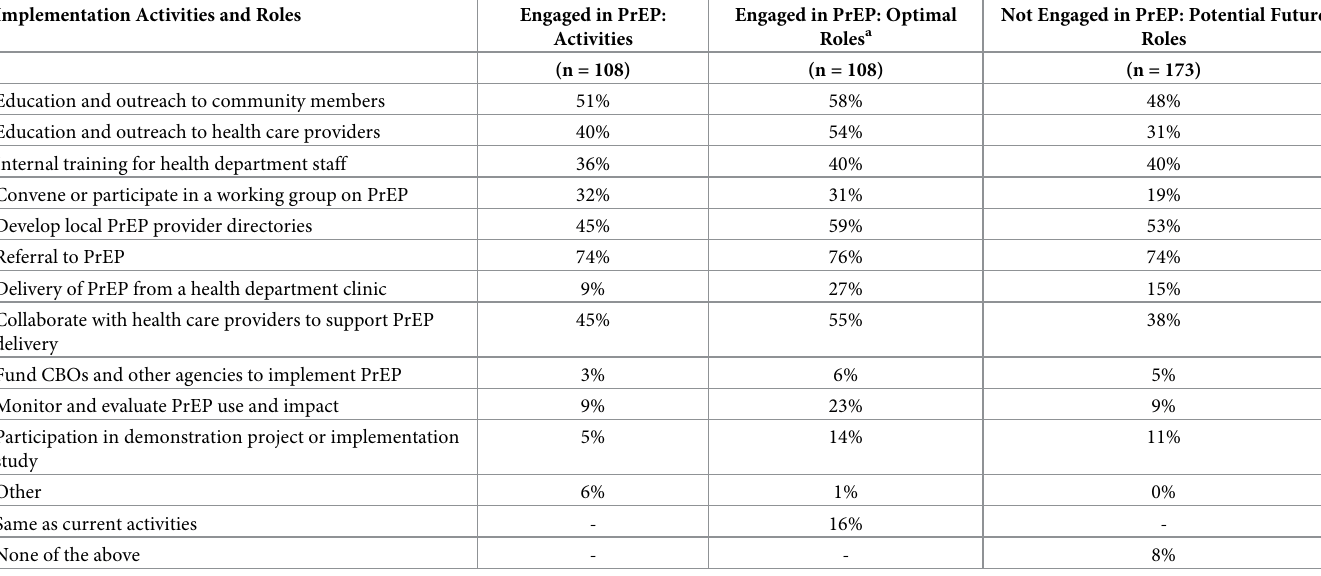
Table 2. Local health department PrEP implementation activities, optimal roles, and potential future roles, United States, 2015, weighted response proportions.